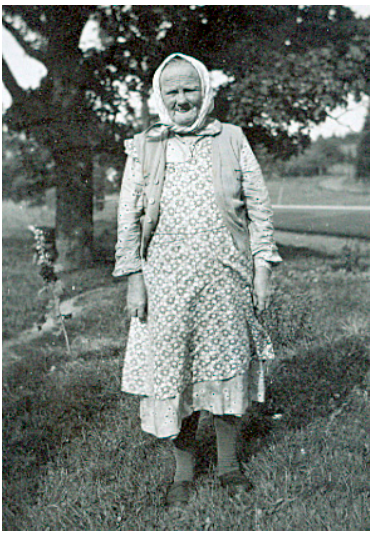
Figure 2. Ellen-Maria lived until 23 October 1951.